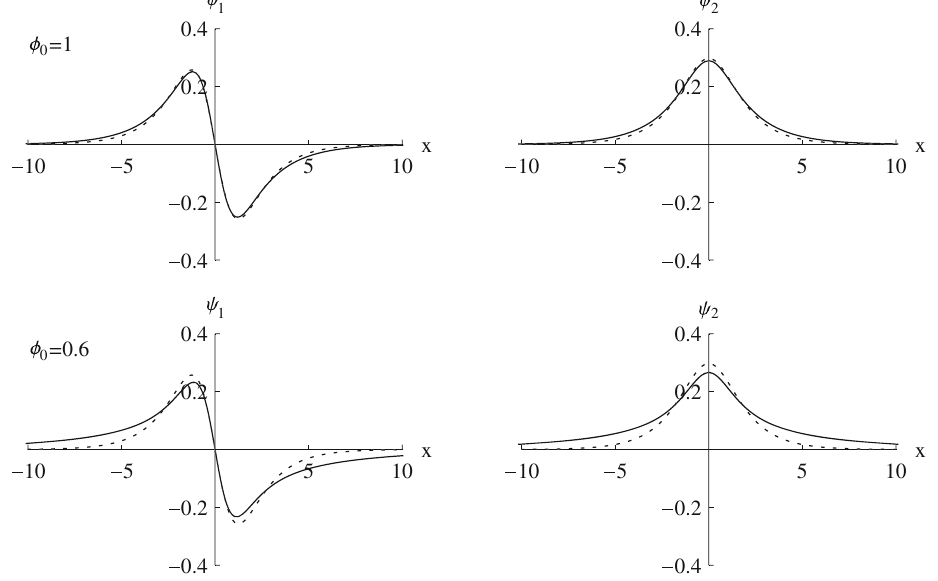
Fig. 5 The negative energy fermionic bound state as a function of x for φ 0 = 1 and φ 0 = 0 . 6. Solid and dashed curves show the fermionic bound state in the dynamical and background models,